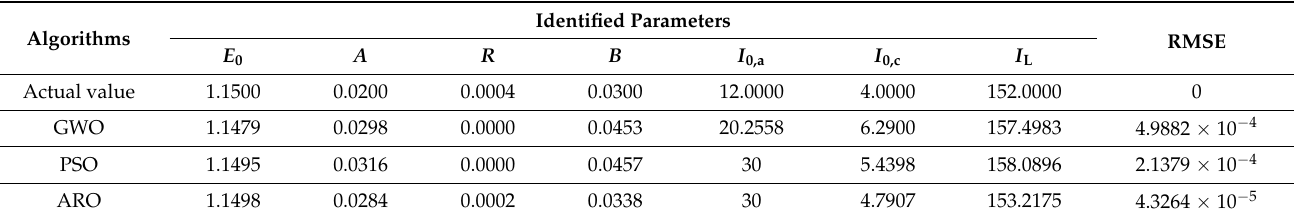
Table 5. Identification results of various